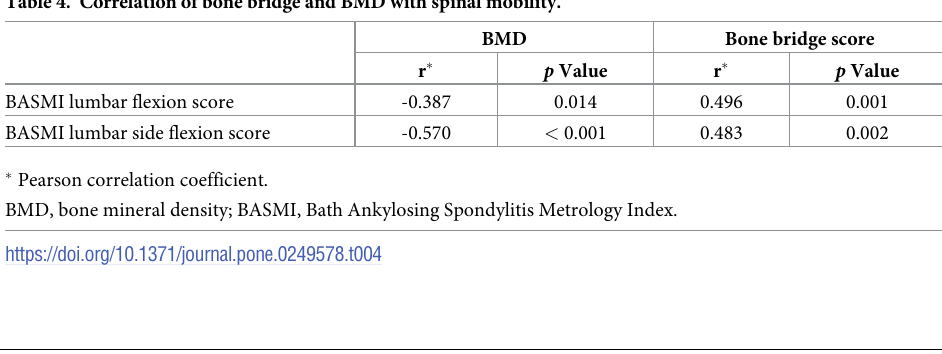
Data presented as mean ± standard deviation. BMD, bone mineral density; QCT, quantitative computed tomography.